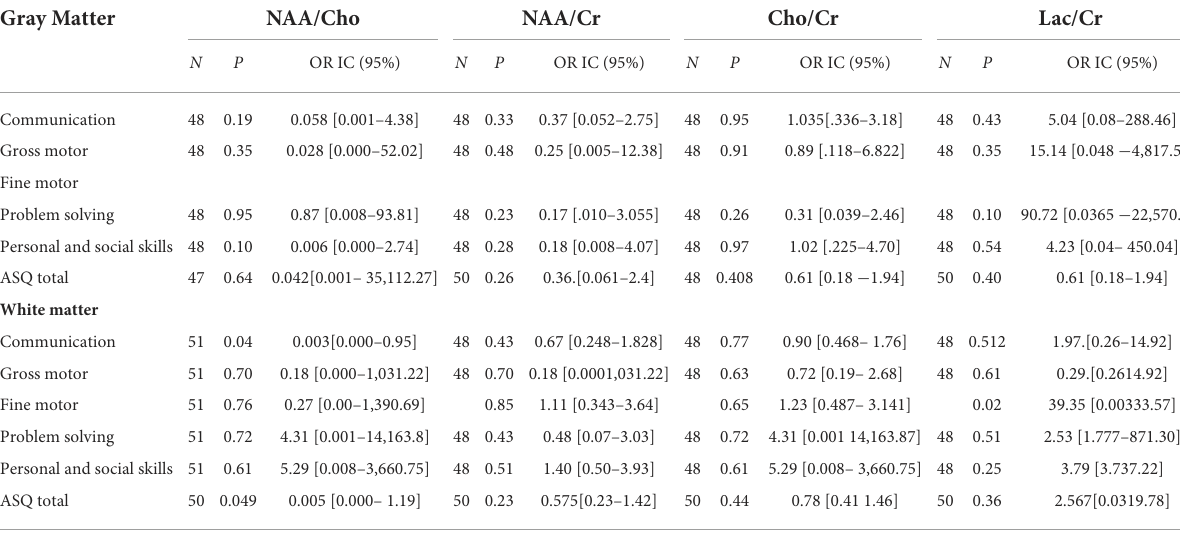
TABLE 7 Correlations between NAA/Cho. NAA/Cr and Cho/Cr / Lac/Cr ratio (GM and WM) with ASQ, in multivariate